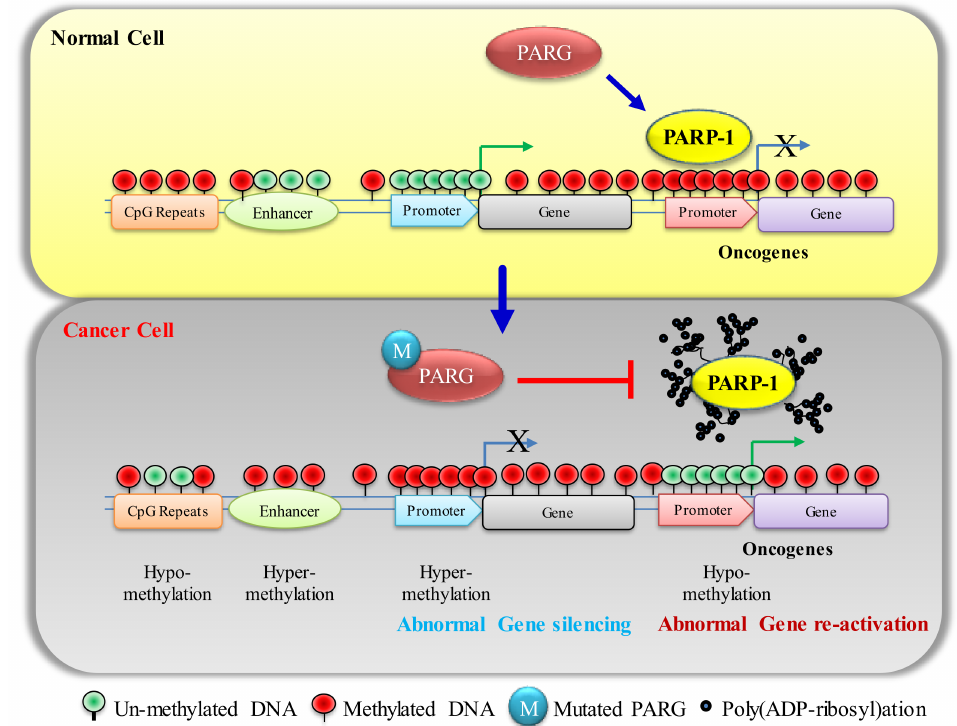
Figure 1. The difference in differential DNA methylation in normal and cancer cells. In PARG or homologous DNA-repair-defective cancer cells the enzymatic activity of PARP1 is increased; therefore, auto-poly(ADP-ribosy)lated PARP1 moves away from the pre-occupied promoter of oncogenes and provides the access to transcription machinery for expression. In downstream, it facilitates DNA hypomethylation at the promoters of oncogenes and make them transcriptional active De novo DNA methyltransferases (DNMTs) promote DNA methylation by catalyzing the transfer of a methyl group from donor S-adenosyl-l-methionine (SAM) to cytosine bases to produce 5mC. The DNMT family consists of five members—DNMT1, DNMT2, DNMT3A, DNMT3B and DNMT3L (Figure 2A) [35,36]. Interestingly, DNMTs’ important actions during DNA methylation may be divided into two categories, methylation maintenance and de novo methylation. DNA